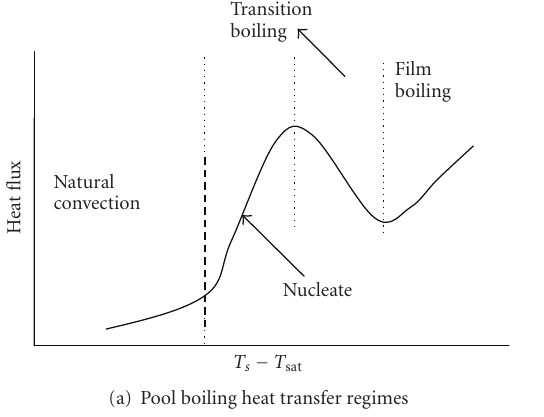
Figure 9: Instability due to boiling